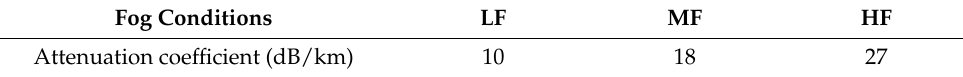
Table 1. Different fog conditions with their corresponding attenuation coefficient [27,28]. Fog Conditions LF MF HF Attenuation coefficient (dB/km) 10 18 27